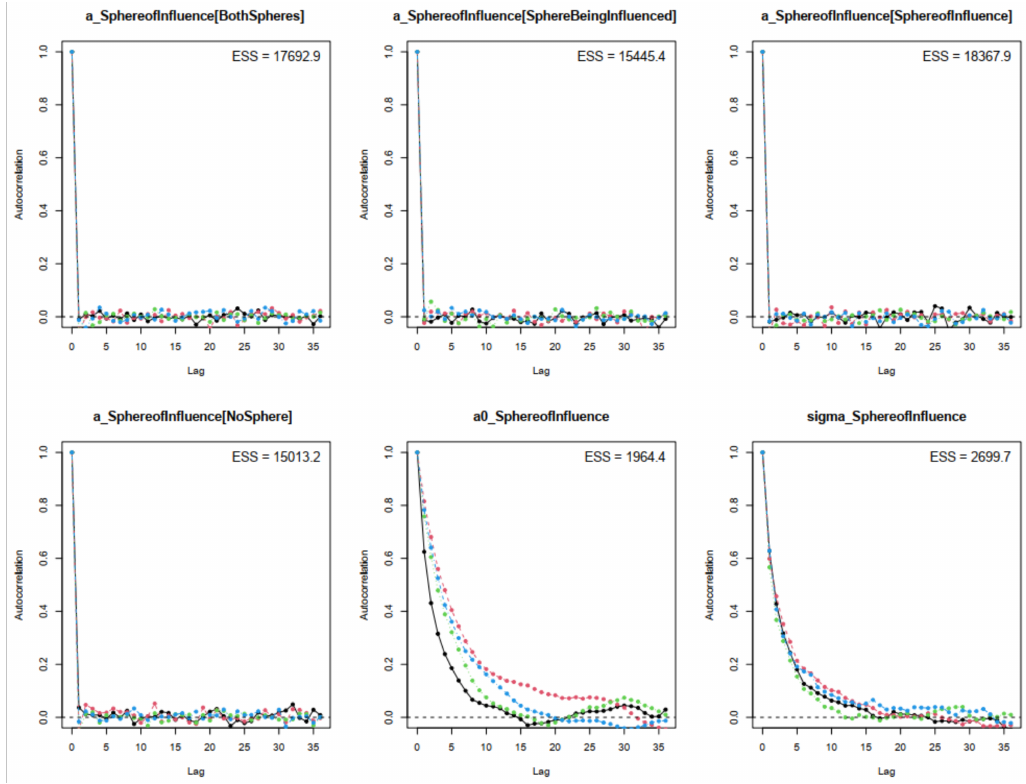
Figure A12. Model 4 (cid:48) s autocorrelation plots.